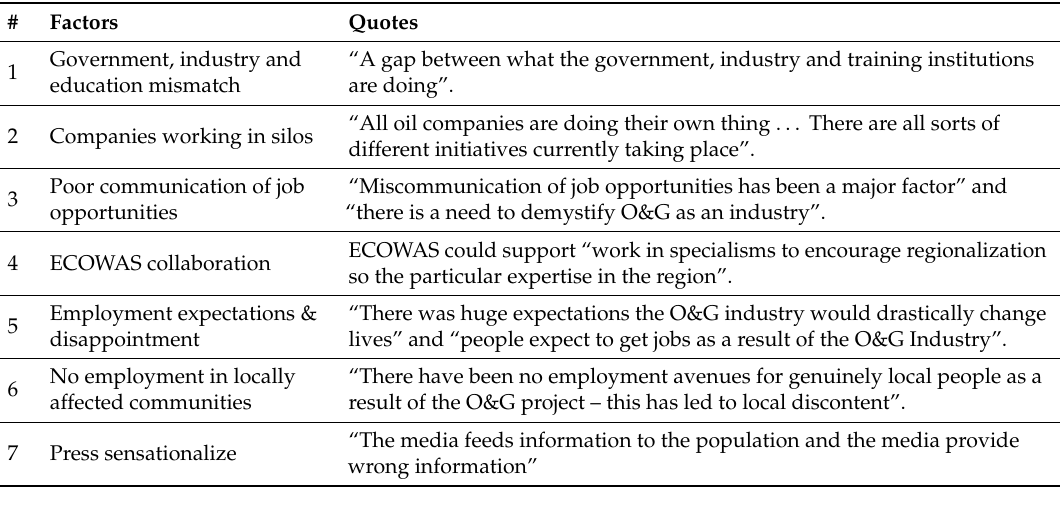
Table 12. ‘Culture and trust’ theme.